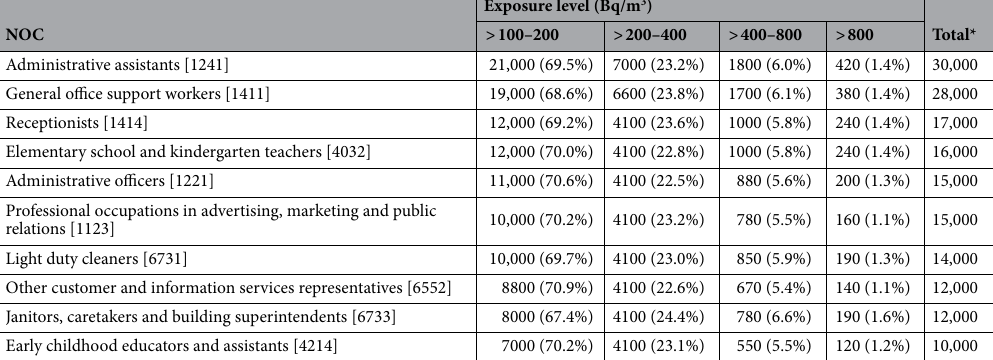
Table 5. Estimated number of workers exposed to radon by level of exposure and top 10 4-digit occupations (NOC 2016). *Number of exposed may not add up to total because of rounding; row percentage in